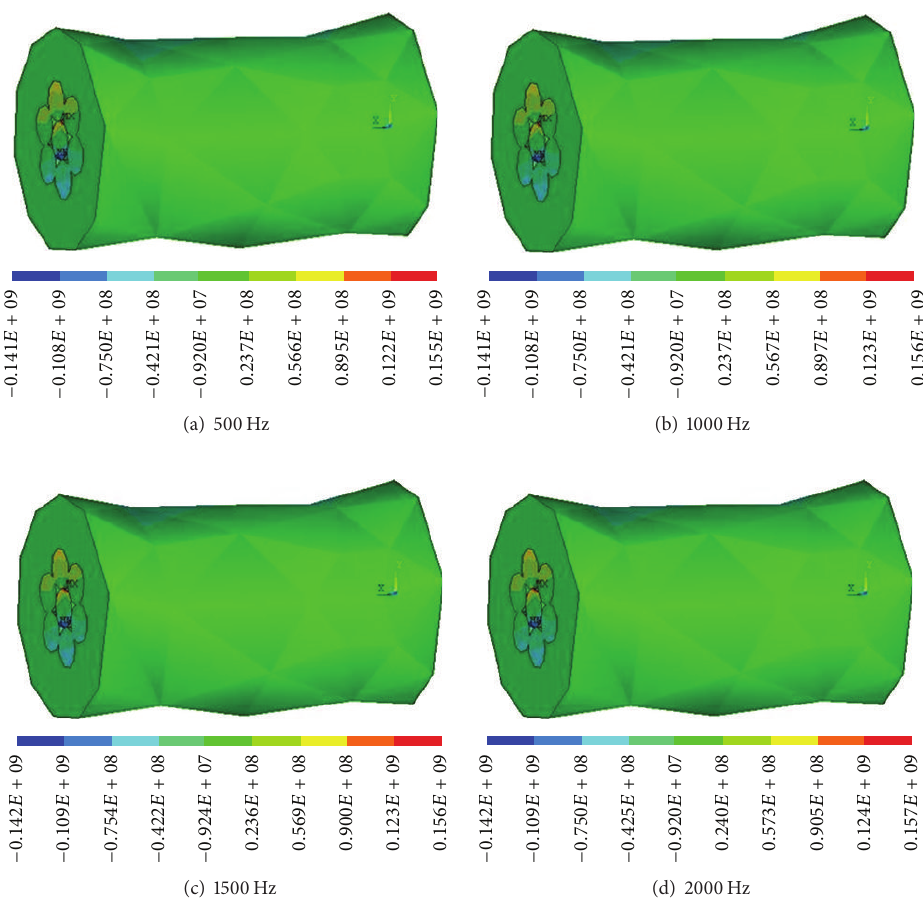
Figure 3: The incentive displacement of 0.25 mm.